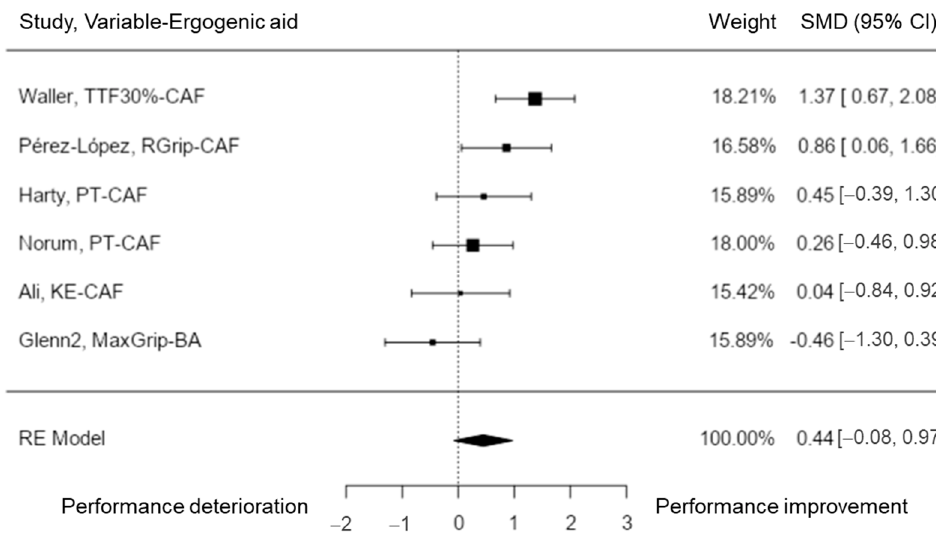
Figure 3. Isometric strength performance forest plot. TTF = time-to-task failure (30% maximal voluntary contraction); RGrip = right hand grip; PT = peak torque; KE = knee extensor.